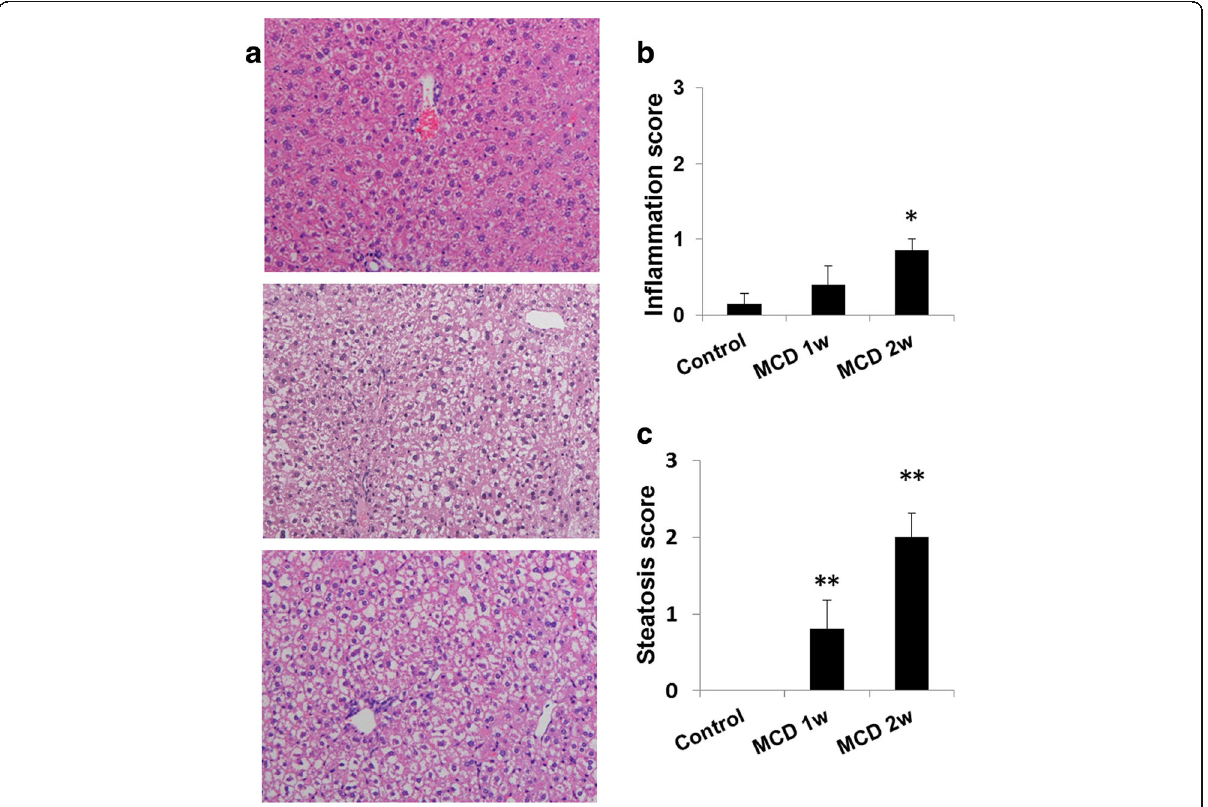
Fig. 2 Hepatic histopathology in mice fed a normal or methionine- and choline-deficient (MCD) diet for 1 or 2 weeks. a Representative photomicrographs of the liver. Histopathological scores ranged from 0 to 4 (normal 0, minimal 1, mild 2, moderate 3, marked 4). Upper, control diet; middle, MCD diet 1 week; lower, MCD diet 2 weeks. b Inflammation score in the liver of treated mice. c Steatosis score in the liver of treated mice. Data are expressed as the mean ± SEM, n = 5 – 7 mice per group. * p < 0.05 and ** p < 0.01 compared with the control mice. Hematoxylin and eosin (H&E), ×